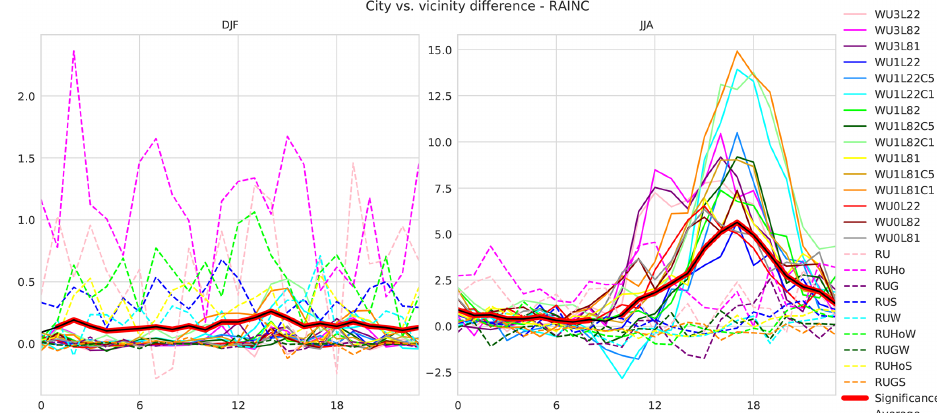
Figure 12. Diurnal cycle of city–vicinity differences for sub-grid-scale precipitation (in mm, differences between seasonal sums).